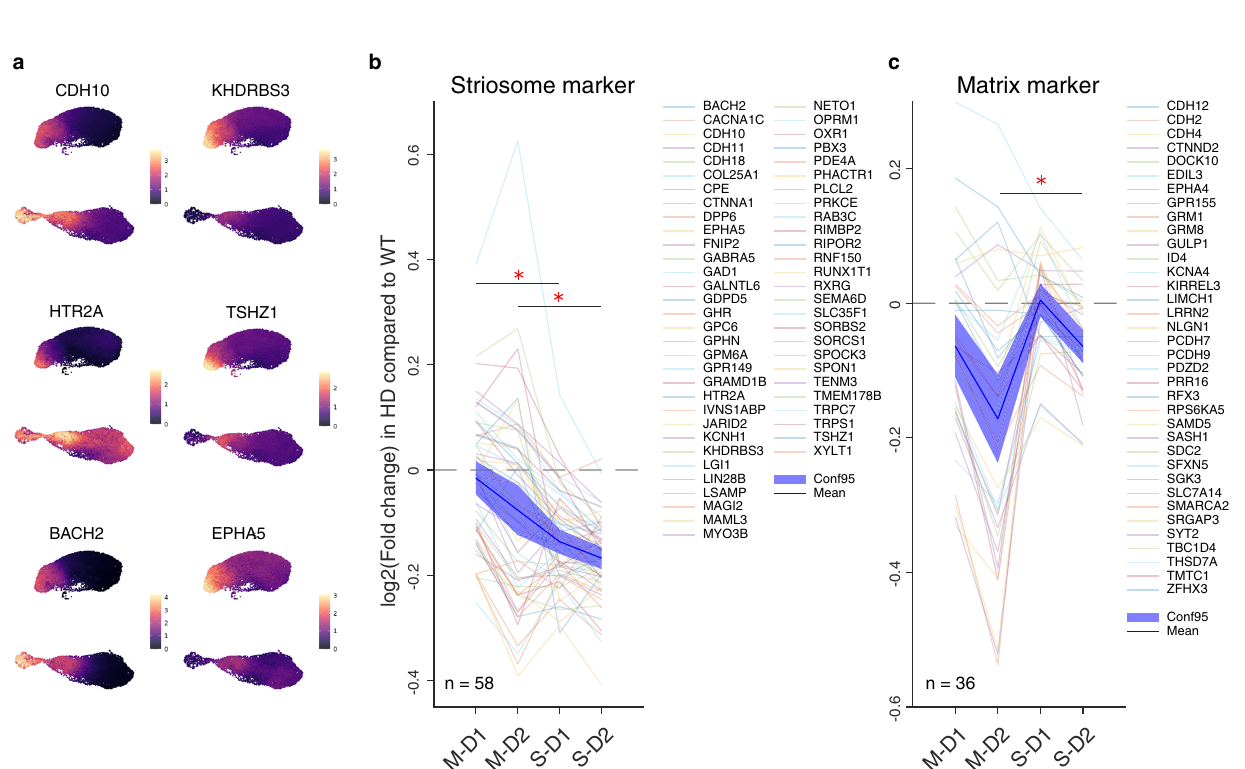
differentiating the compartments only in D1 ( d – f ) or D2 ( g – i ) population. j ,AlterationofdSPN(left)andiSPN(right)markerexpression,whichdifferentiated D1-D2SPNsinbothcompartmentsincontrols,foreachmodel.Nindicatesnumber of markers included in each panel. Error bars indicate 95% con fi dence intervals for the averages. k , l Alterations of D1 ( k ) or D2 ( l ) marker expressions in j , shown for eachcelltypeofeachmodel. m – r Sameasin j – l ,butformarkersdifferentiatingD1- D2 SPNs only in striosomes m – o or in matrix p – r . See also Supplementary Fig. 6.